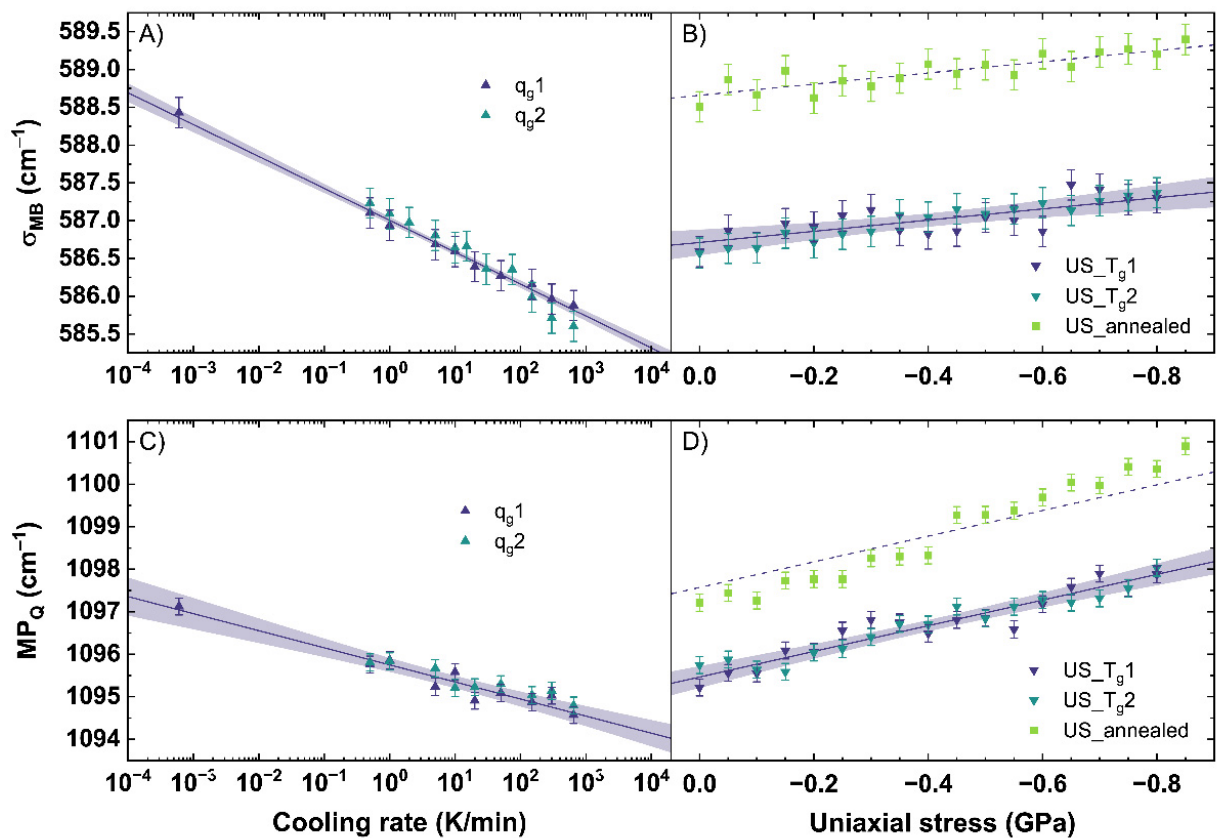
Figure 5. ( A ) σ -parameter of the main band ( σ MB ) for a change of cooling rate ( q g ) and ( B ) under different uniaxial stress ( US ). ( C ) maximum position of the Q-range ( MP Q ) for a change of q g and ( D ) under different US . q g 1 and q g 2 are indicated by the dark blue and cyan up triangles. US_T g 1 and US_T g 2 are displayed by the dark blue and cyan down triangles. US_annealed is indicated by light green squares. The shaded areas show the 95% confidence interval of the linear fits.